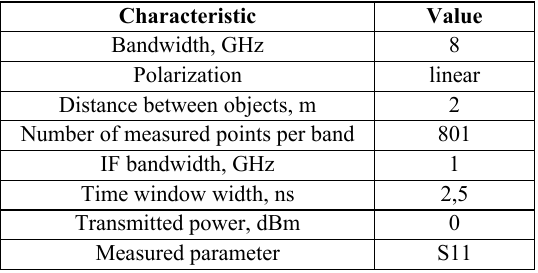
Table 1. Measuring bench